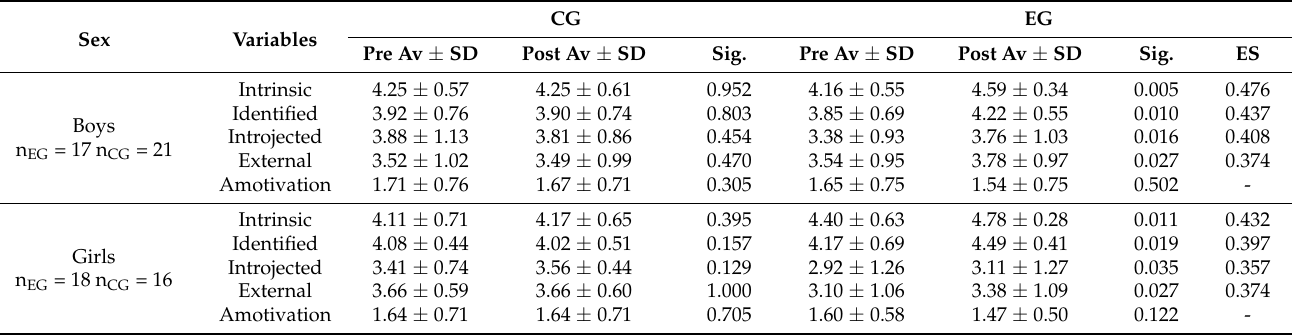
Table 3. Effects of the didactic unit for the CG and the EG in the different regulation motivational variables analyzed in the entire sample and segmented by sex (Av ±